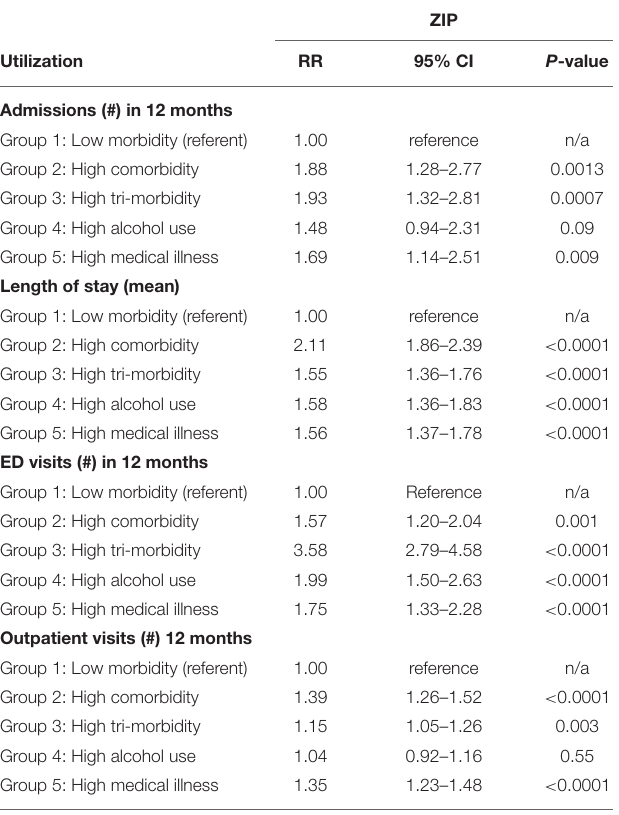
ZIP Clinical outcome